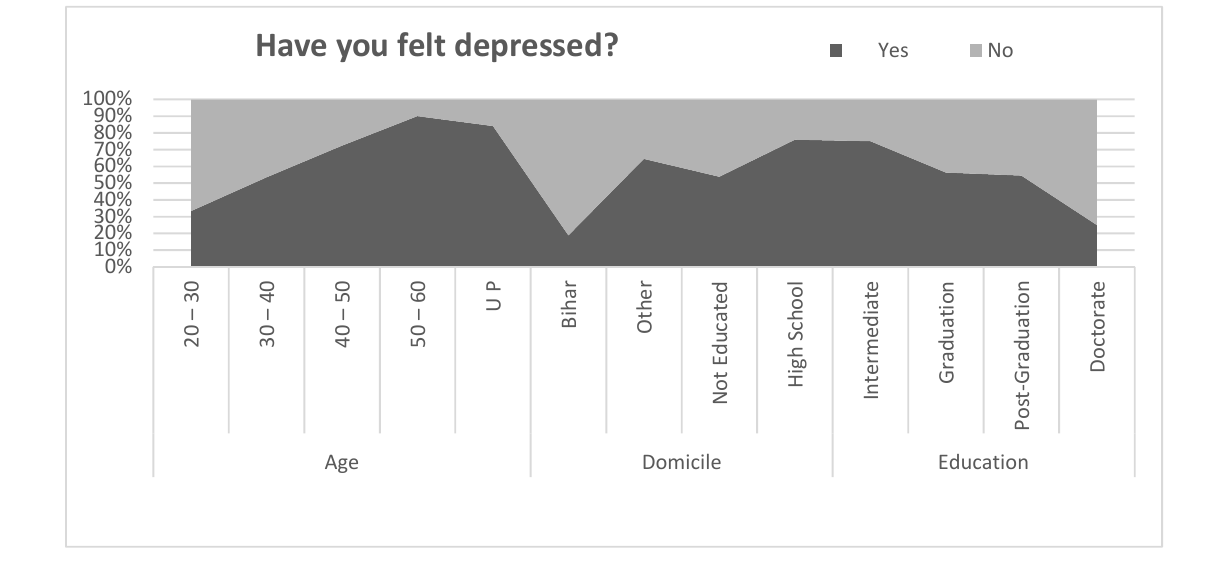
Figure 4. Comparison of feeling depressed. Table 11. Comparison of psychological effect by number of family